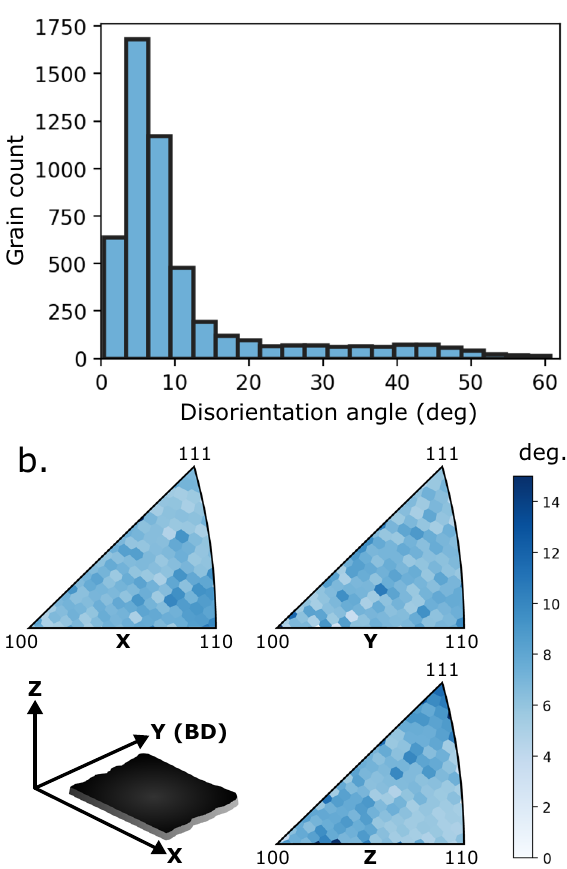
Fig. 5 Evaluation of EulerNet performance. a The disorientation angle between the predicted orientation and the EBSD ground truth is centered around 5-8°. b The disorientation angle is marginally higher in the vicinity of the {111} γ orientation out-of-plane (Z) and is otherwise mostly uniform across the other